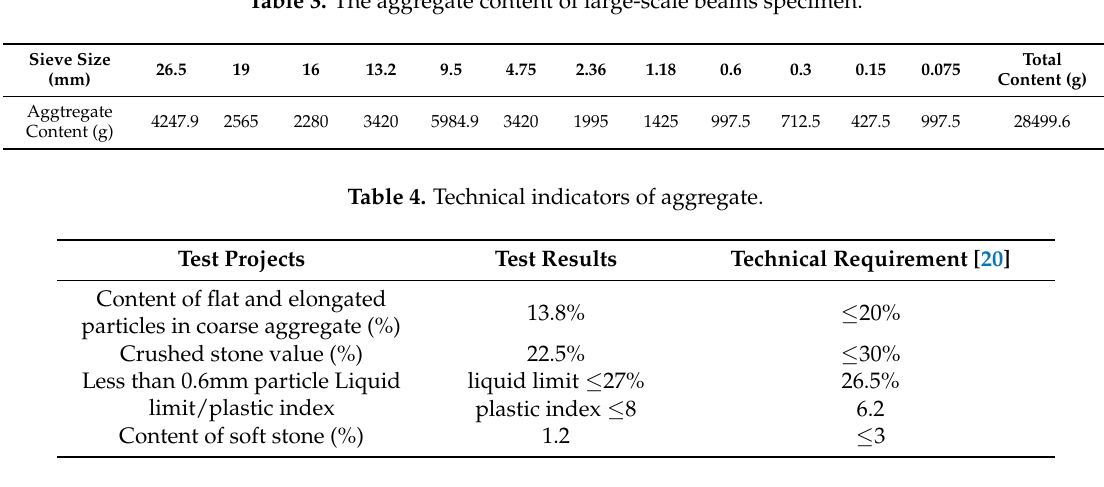
Table 3. The aggregate content of large-scale beams specimen.